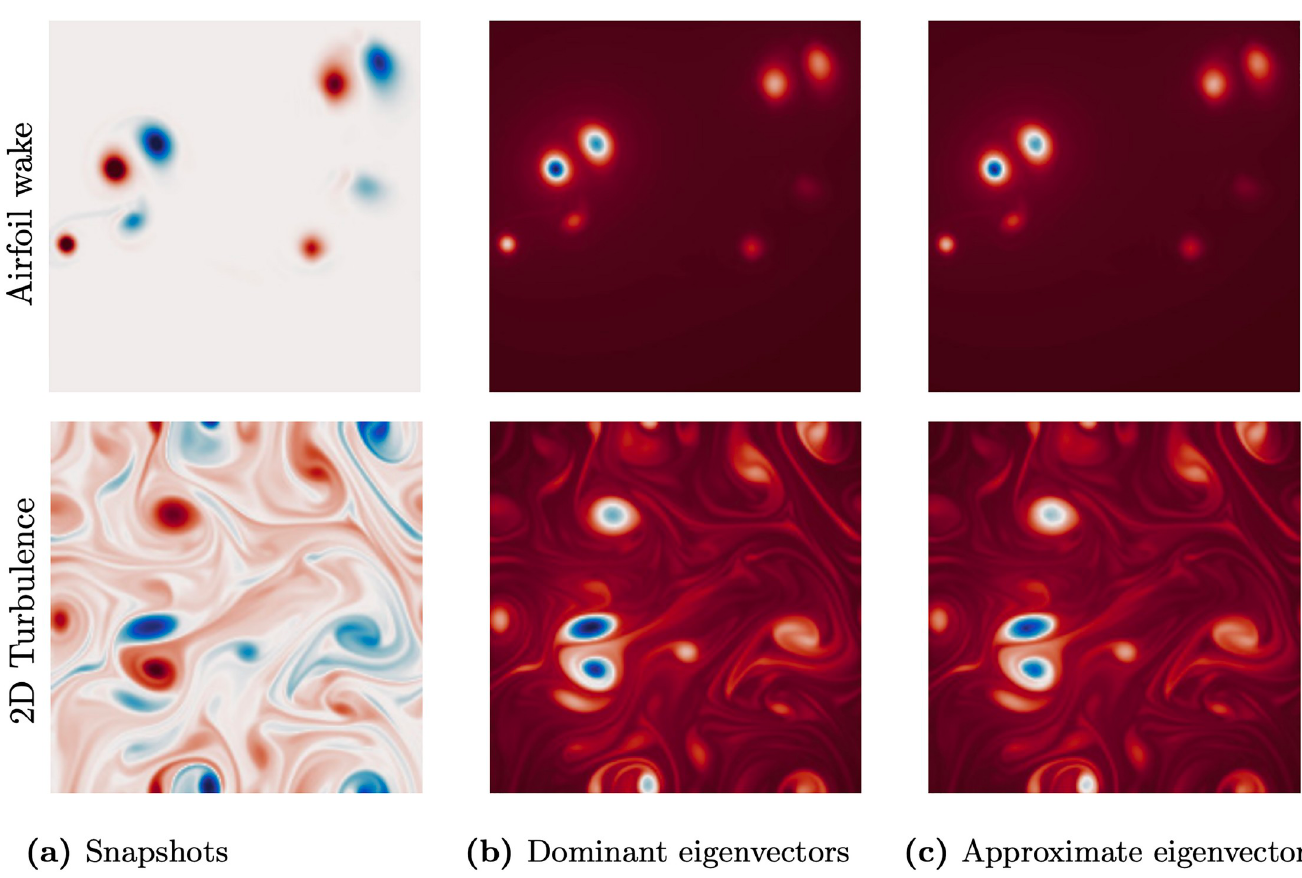
Fig 6. Qualitative comparison of the deterministic (b) and approximate (c) dominant eigenvector of the adjacency matrix generated from the flow field in (a). The top row shows the results for the airfoil wake and the bottom shows the results for the two-dimensional isotropic turbulence. The approximation in (c) uses the Nystro¨m method with Halton sampling with 10% of the columns of the adjacency matrix.